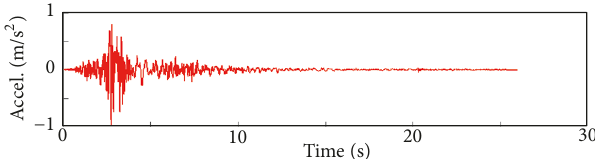
󳨀→ 𝑎 푠 as a function of